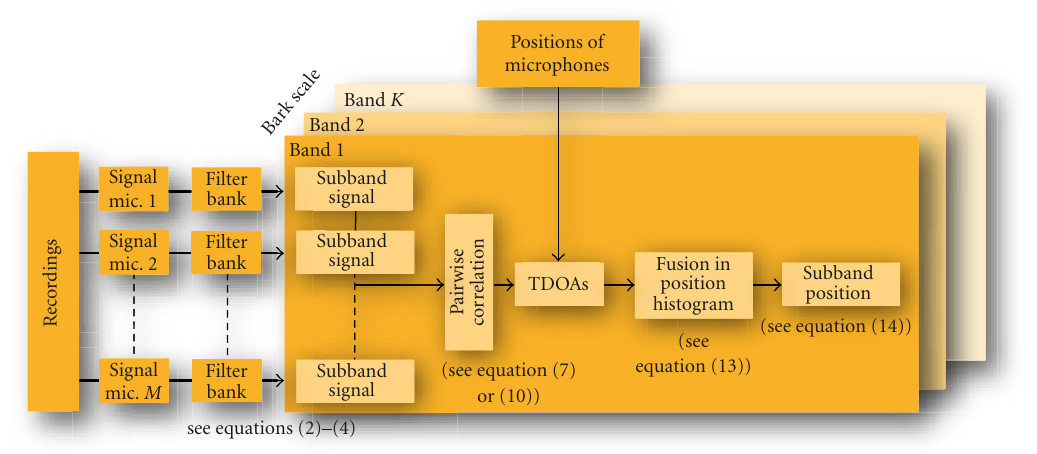
Figure 4: Overview of the analysis algorithm used to construct a spatial mapping for the acquired soundscapes.